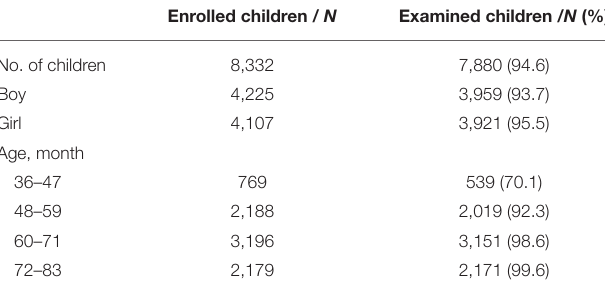
TABLE 2 | Demographic characteristics of the study